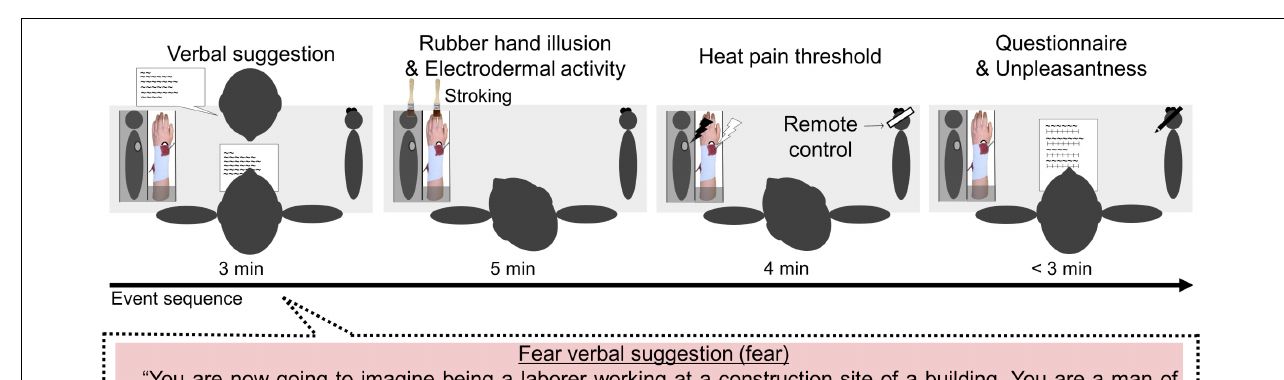
FIGURE 4 | Relationship between ownership of questionnaire and HPT in Experiment 1 (A,B) .